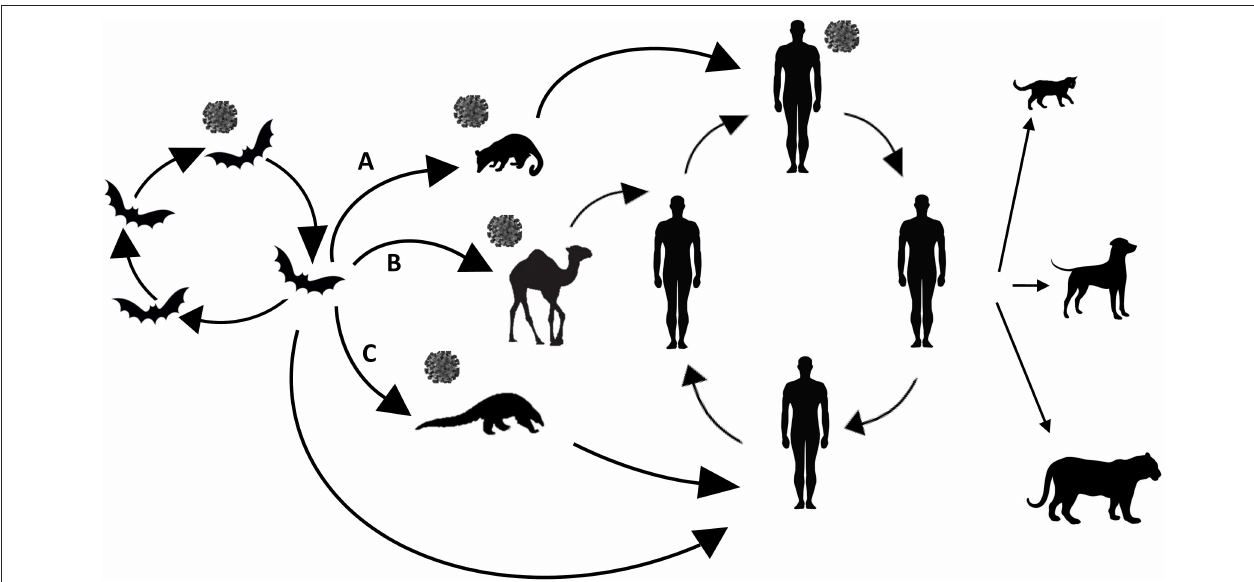
FIGURE 1 | Animal origin of human coronaviruses. SARS- CoV (A) emerged from bats, infected civets and humans and adapted to these hosts before causing the SARS epidemic. MERS- CoV (B) likely spilled over from bats to dromedary camels. SARS-CoV-2 (C) emerged from bats spilled over to human either directly or by previous infecting pangolins. Reverse zoonosis transmission (from human to cats, dogs, and tiger) refers only to